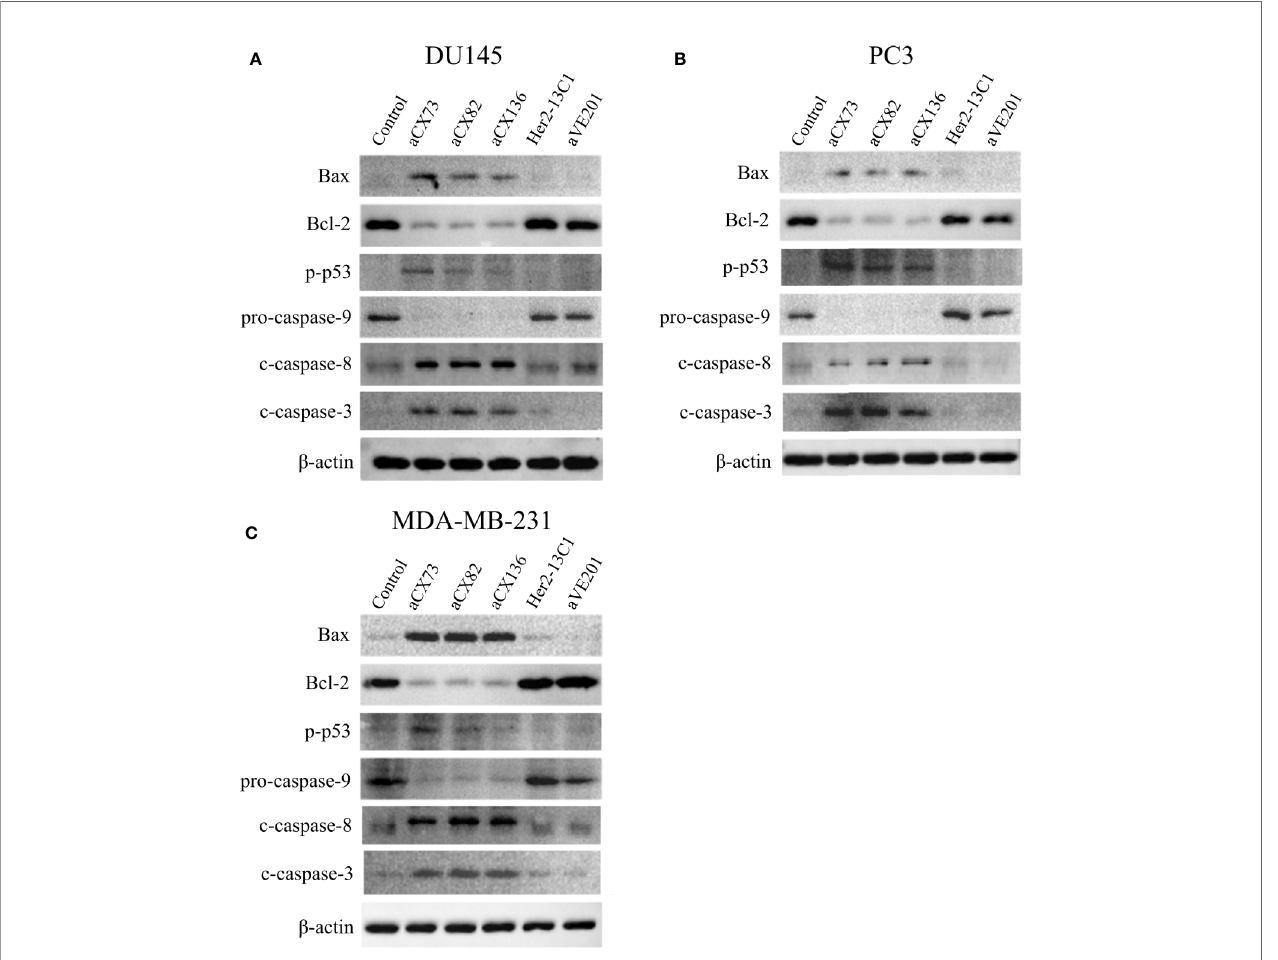
FIGURE 7 | Expression of the apoptosis-related proteins was examined by Western blot analysis. Cells were treated for 48 h with anti-CXCR4 scFvs (aCX73, aCX82, and aCX136), negative control antibodies (Her2-13C1 and aVE201), or PBS as a control. Effect of the antibodies on the expression of the apoptosis-related proteins was tested in DU145 (A) , PC3 (B) , and MDA-MB-231 (C) . b -actin was used as an internal control. Western blots were analyzed using ImageJ